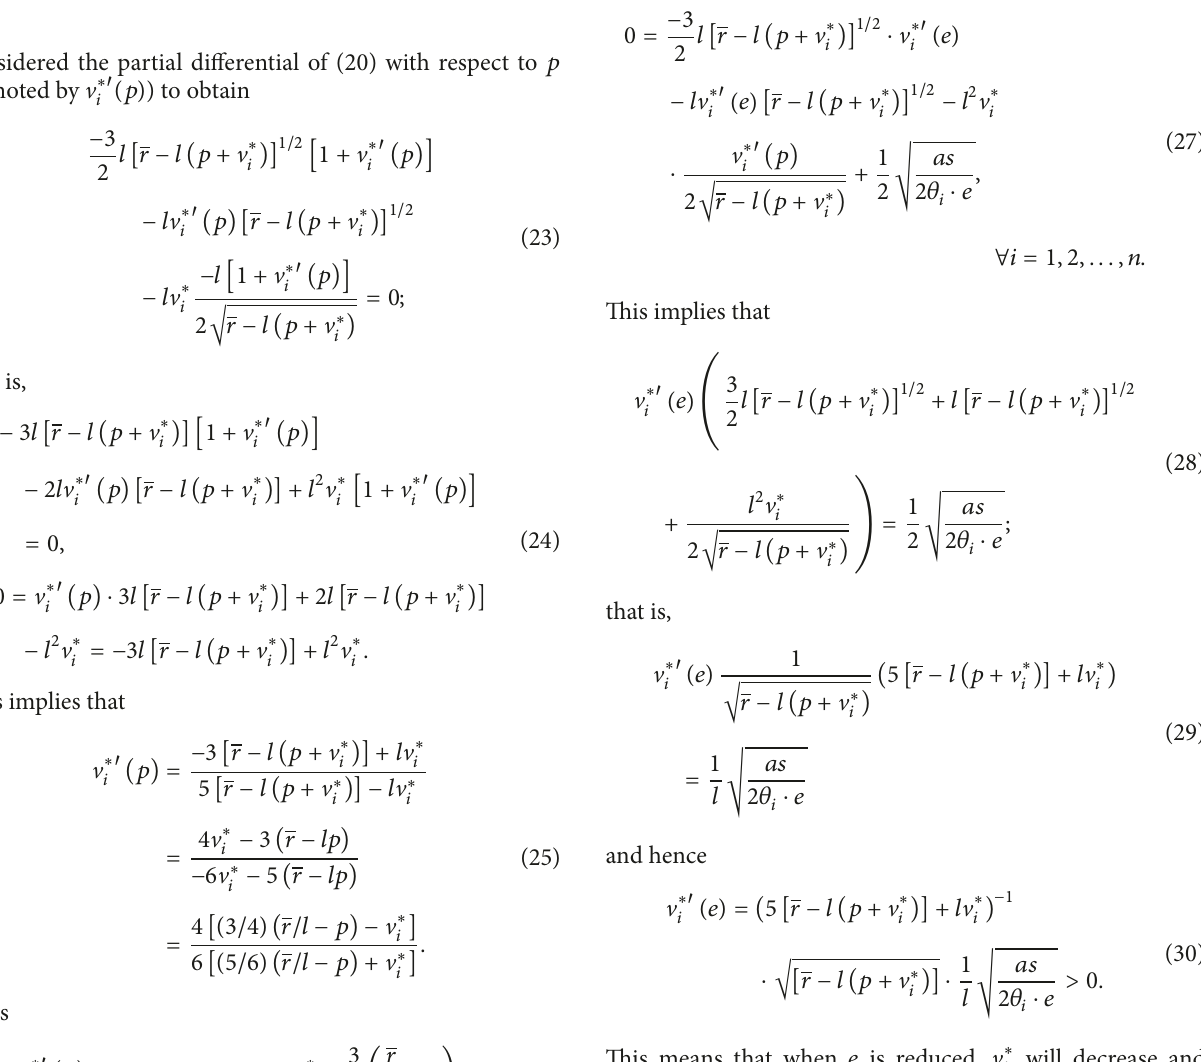
Figure 1: Optimal gross profit V ∗ 𝑖 of retailer 𝑖